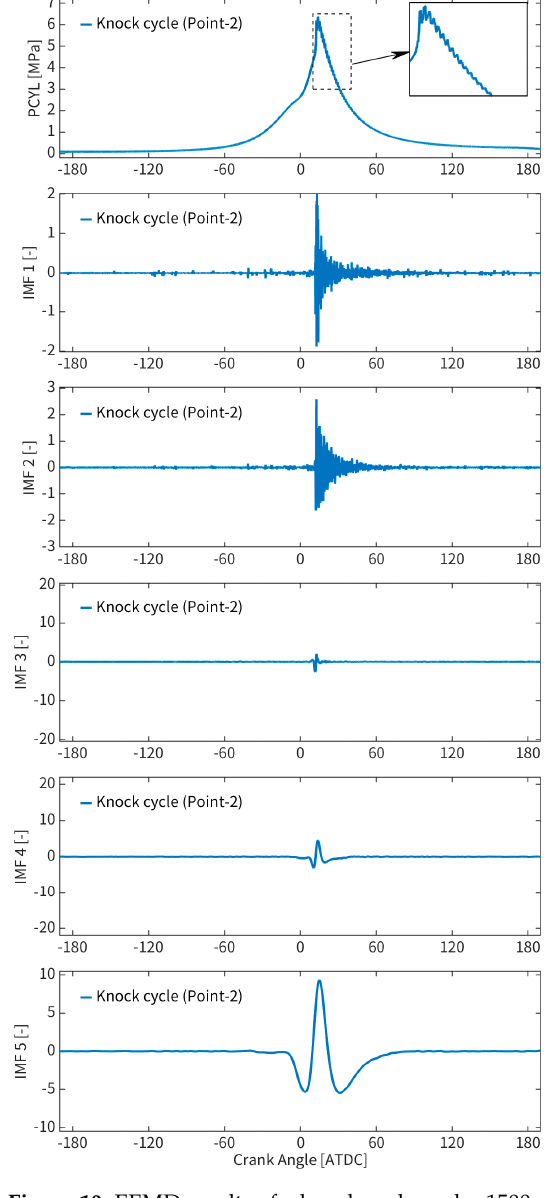
Figure 10. EEMD results of a knock cycle under 1500 rev/min, 600 kPa BMEP (Point 2).